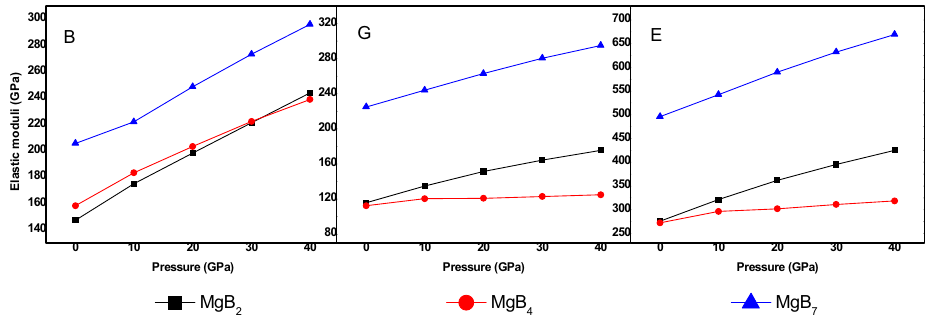
Figure 5. Elastic modulus (B, G, and E) of Mg–B compounds various from different